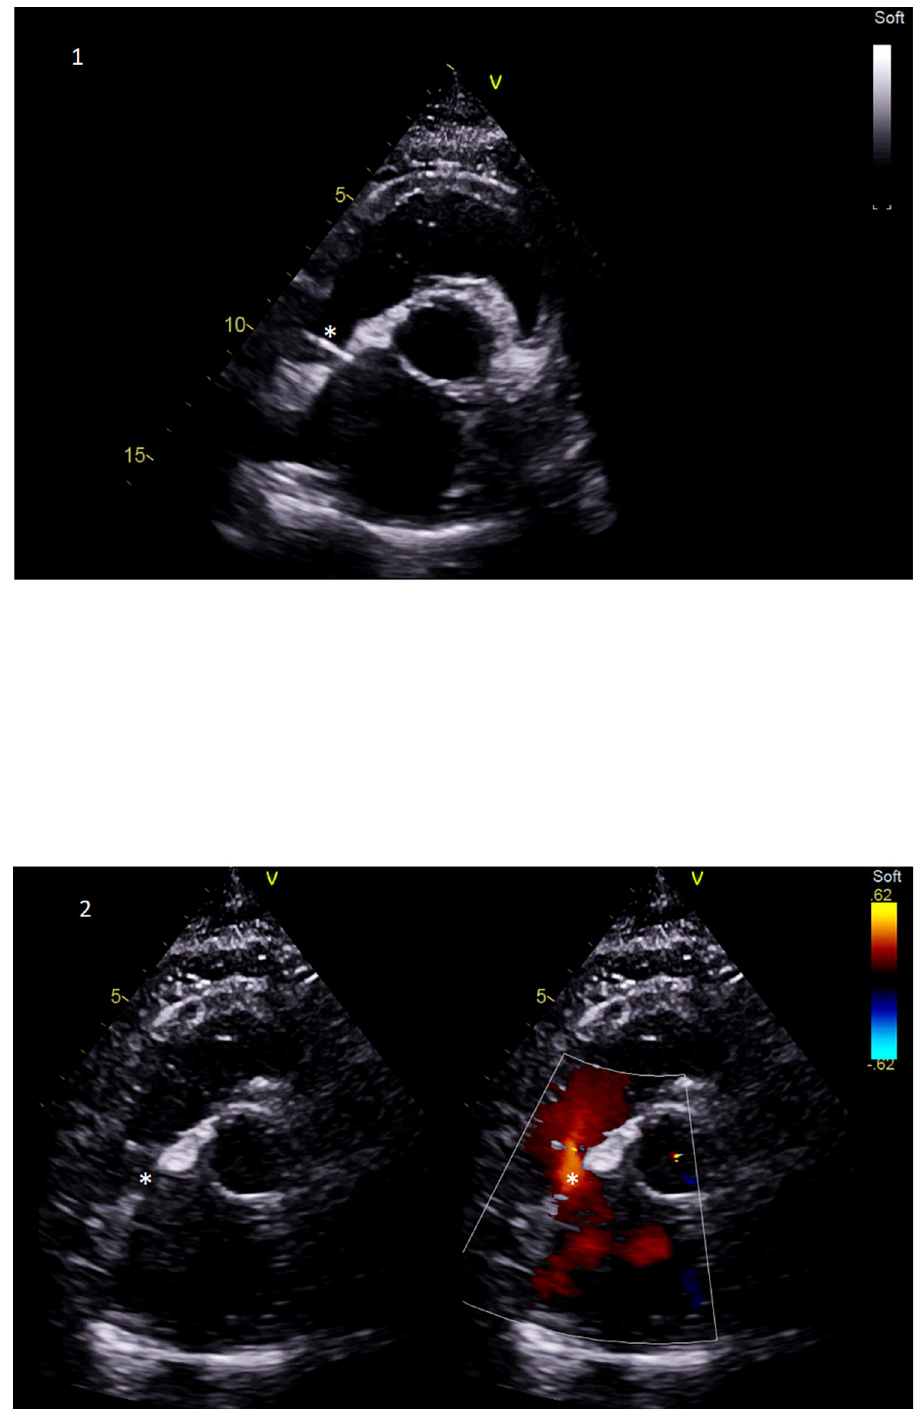
Fig 1. Brockenbrough technique to create an ASD. * Brockenbrough needle on picture 1 for atrial trans-septal puncture. * After the creation of an ASD shunt on picture 2, the red color stands for the left-to-right shunt through the